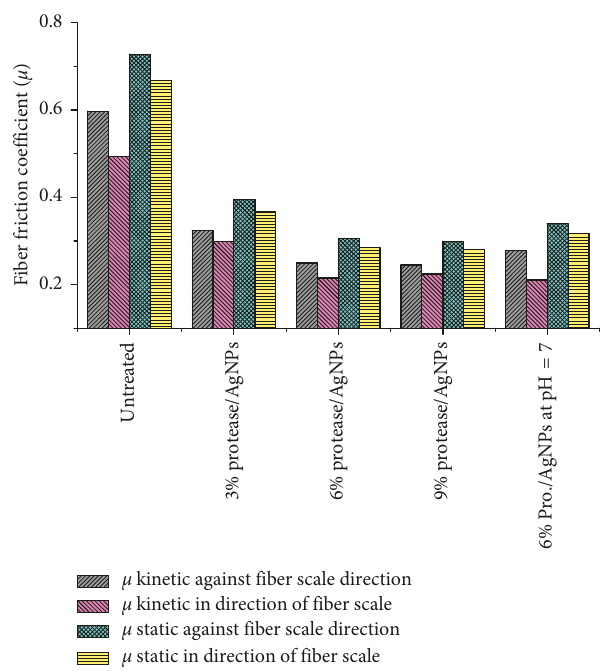
Figure 8: The fiber friction of treated wool fibers.